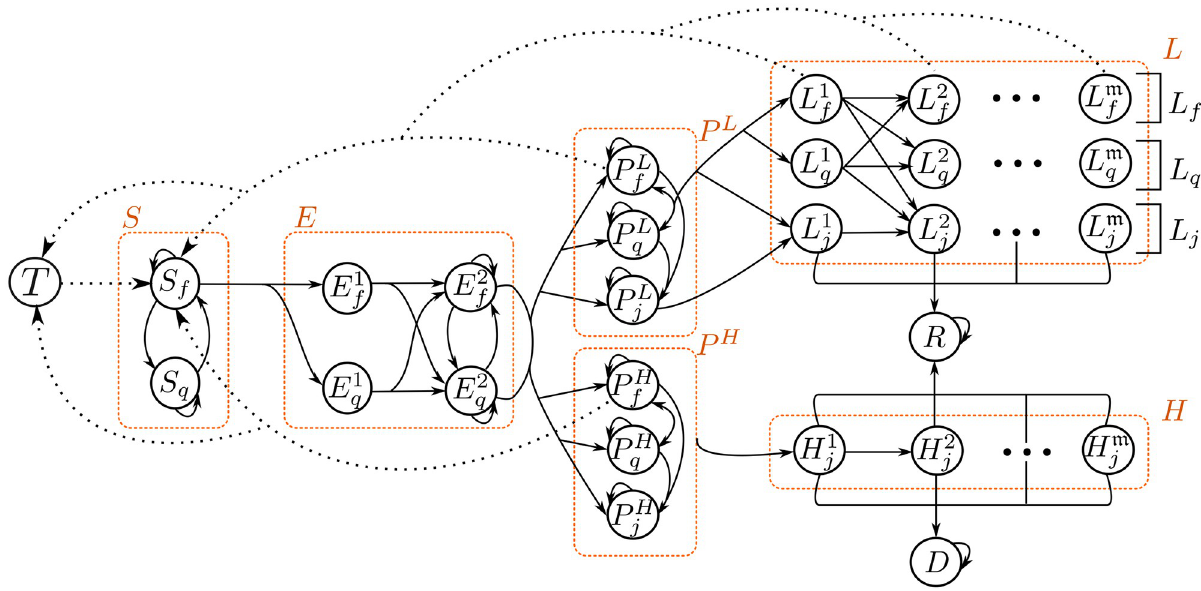
Fig 4. The model built from the basic structure proposed in section 2.2 and Fig 1. Note that both structures share the same compartments but extend some in sub-compartments such as quarantine, free circulation, and identified cases. We define the symptomatic compartments as diffusion systems, representing the recovery and death of the disease process. For further information about the diffusion systems, see section